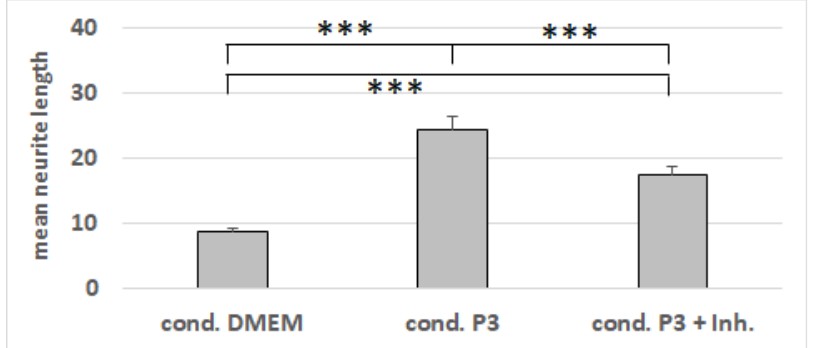
Figure 11. Lengths of neurites in µm on NG108-15 cells after cultivation with conditioned Protocol-3 medium, with or without NGF-neutralizing antibodies. The mean value and standard error of the mean for each condition are shown. ***: p -value < 0.001.